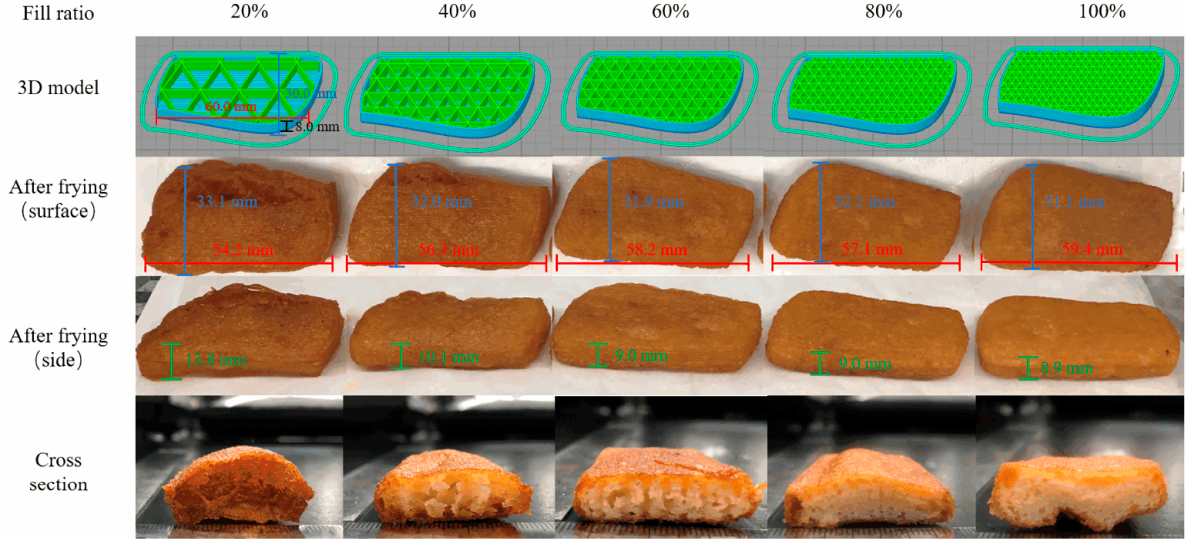
Figure 5. Fried of 3D printed samples with different (20–100%) infill ratios. Table 6. Texture and moisture results of samples with different infill ratios after frying.